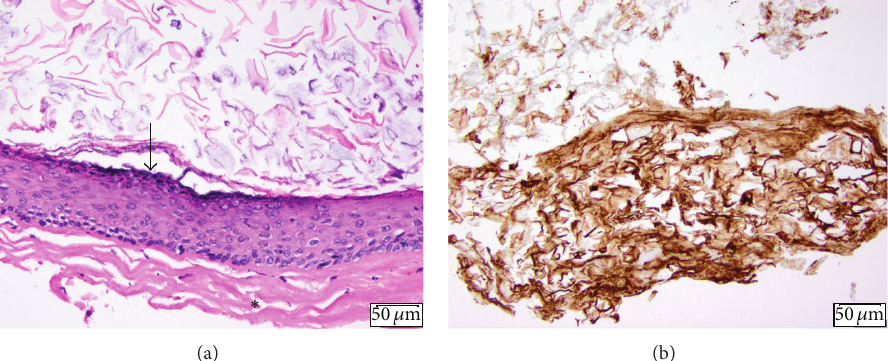
Figure 4: Histopathology images from case 1. (a) Iris implantation cyst lined by stratified squamous epithelium (arrow) with a large amount of keratin debris with the cyst cavity. Fibrosclerotic material is seen surrounding the cyst wall (asterisk). (b) Positive immunohistochemistry for pankeratin cocktail, confirming the cyst contents to be keratin